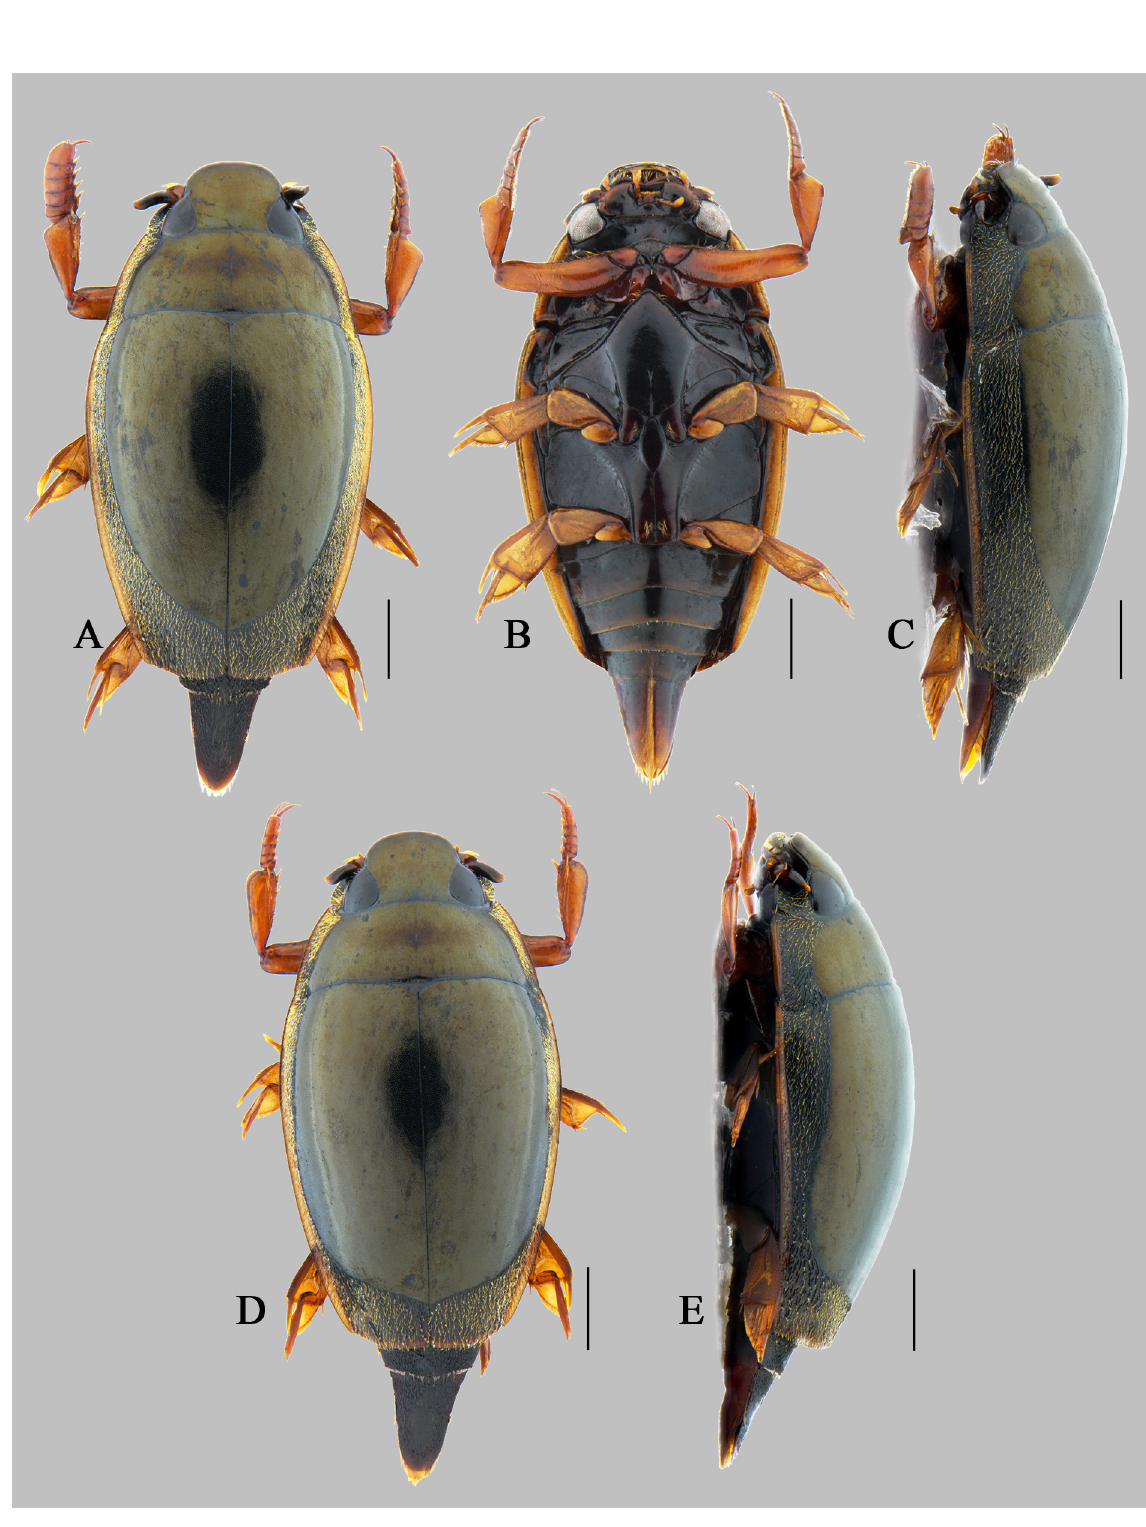
Fig. 2. Habitus of Patrus shangchuanensis sp. nov., paratypes (SYSU). A . ♂, dorsal view. B . ♂, ventral view. C . ♂, lateral view. D . ♀, dorsal view. E . ♀, lateral view. Scale bars = 1